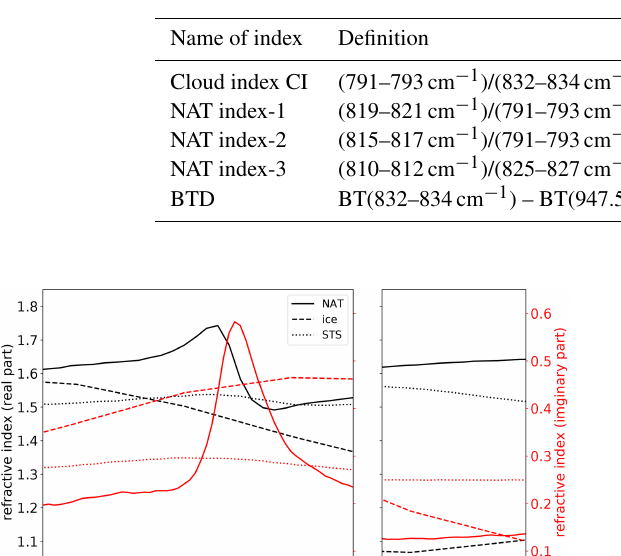
Table 4. Summary of the indices and their corresponding micro-windows.